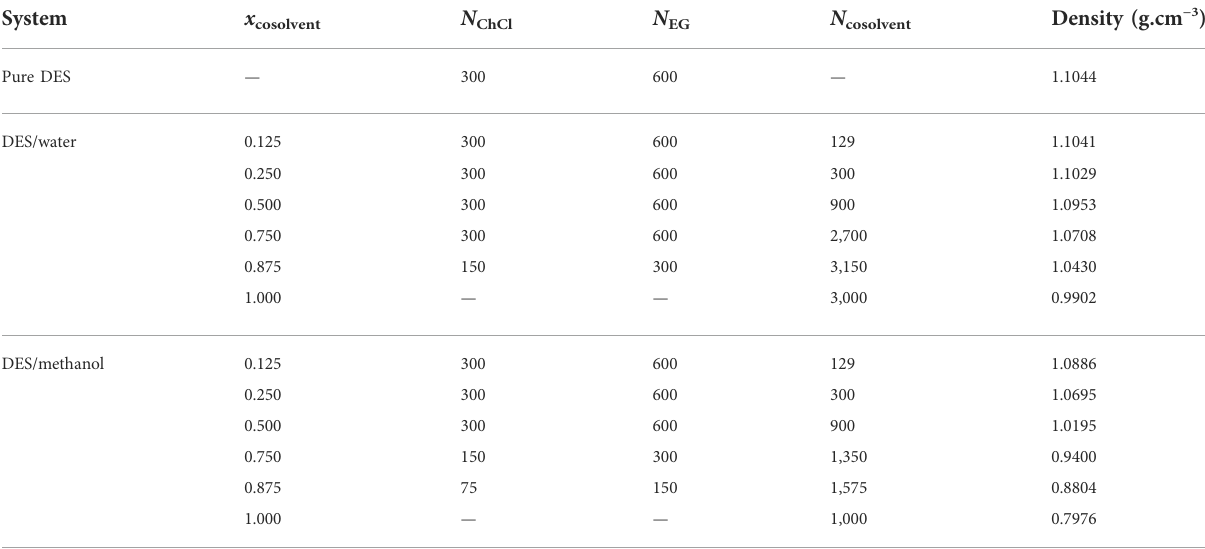
TABLE 1 Details of simulated DES/cosolvent mixtures and respective pure solvents. The total number ( N ) of units/molecules of each component (choline chloride ChCl, ethylene glycol EG, and water/methanol cosolvent) and the simulation average densities (308 K, 0.98 bar) are shown. System x cosolvent N ChCl N EG N cosolvent Pure DES —